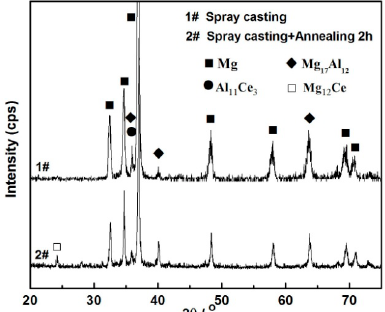
Figure 8. XRD patterns of spray-casted AZ91D+0.75Ce alloy and that after annealed at 420 ° C for 2 h.